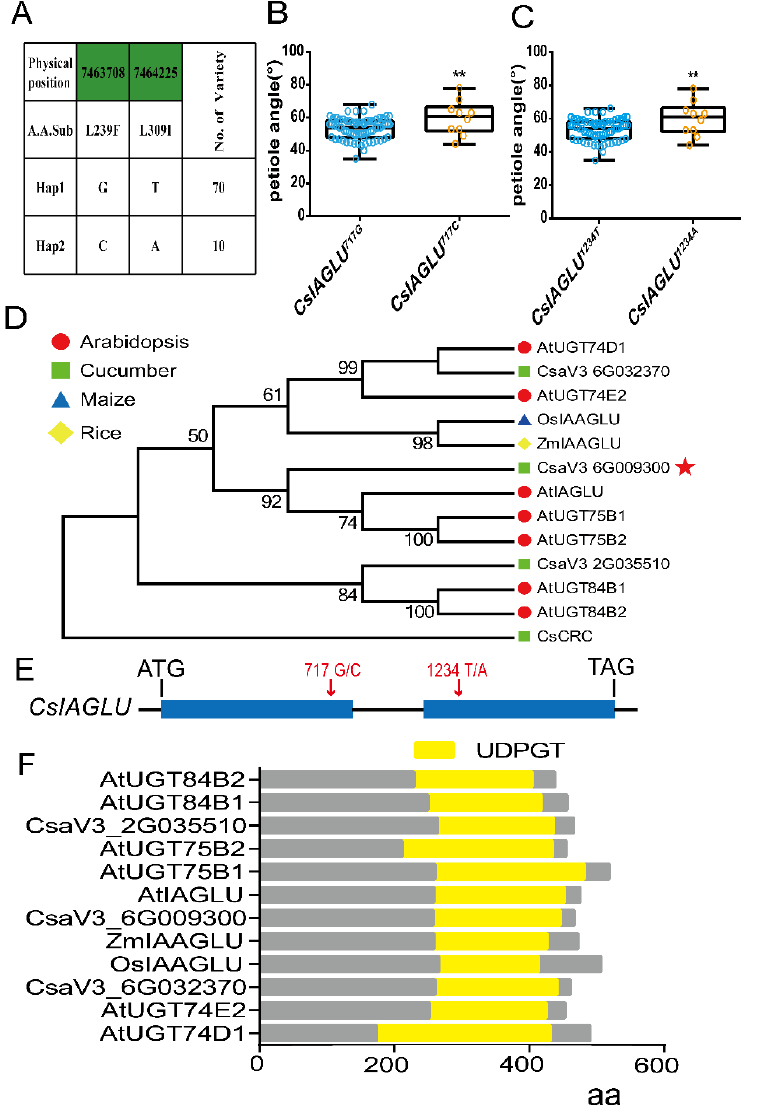
Figure 1. Identification of CsIAGLU in cucumber: ( A ) Two haplotypes of CsIAGLU are defined by the variants, and the accession numbers of each haplotype are labeled on the right. ( B , C ) Boxplots of distribution of LPAs in 80 cucumber lines containing different CsIAGLU haplotypes, CsIAGLU 717G/C ( B ) and CsIAGLU 1234T/A ( C ). Median values are indicated by horizontal lines within boxes, and the range of the 25% to 75% of the data is represented by the box height. A significance analysis was conducted with the two-tailed Student’s t-test (** P < 0.01). Values are means ± SDs. ( D ) Phylogenetic tree of the IAA glucosyltransferase proteins from thale cress, cucumber, rice and maize. The red star represents CsIAGLU in cucumber. ( E ) Schematic diagram of the gene structure of CsIAGLU . The black line represents introns, and the blue boxes represent exons. ( F ) Domain analysis of CsIAGLU homologous protein. The yellow boxes represent the UDPGT (UDP -gluconeosyl and UDP -glucosyltransfer) domain.